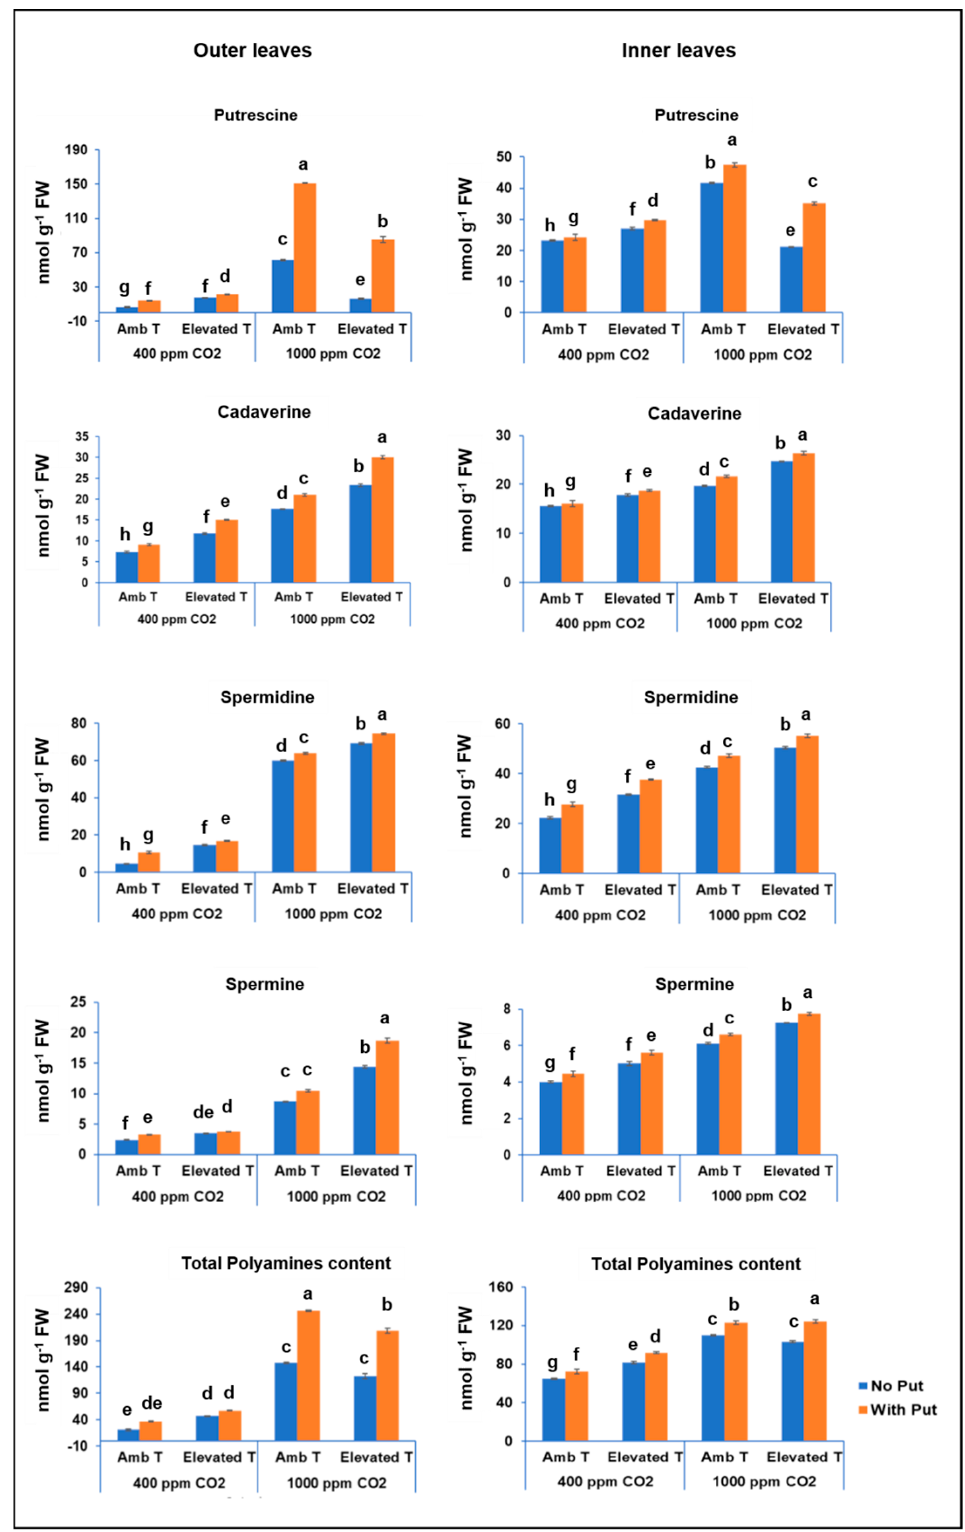
Figure 5. The effect of the foliar application of putrescine on the concentrations of polyamines (nmoles g − 1 ) in the outer and inner leaves of the cauliflower cv. Moonshine at different CO 2 concentrations and temperatures. The data are presented as the treatment means ( n = 5). Different small letters represent significantly different mean values according to Tukey’s test at p ≤ 0.05.